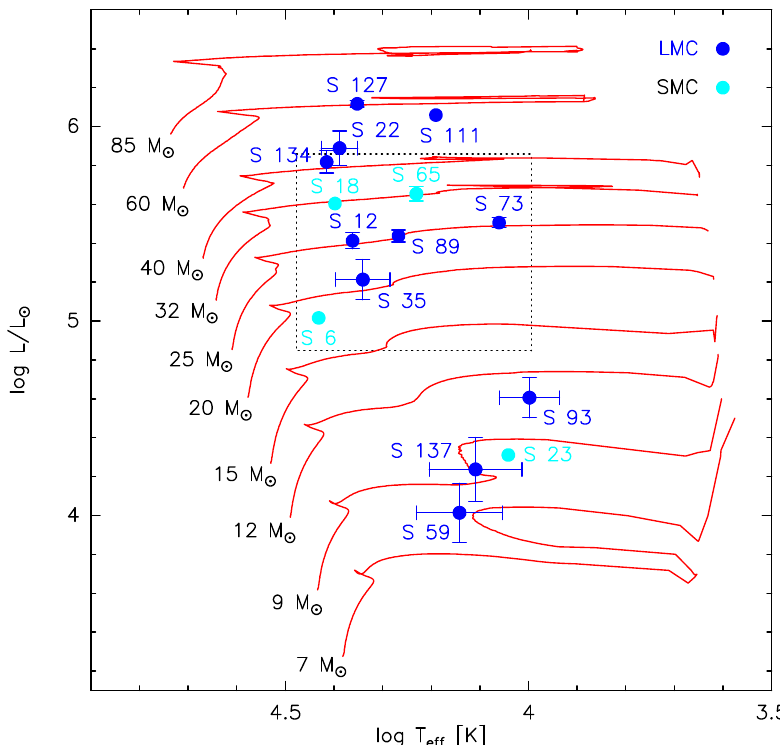
Figure 1. HR diagram showing the positions of the classical MC B[e]SG sample [18]. The stellar evolutionary tracks at SMC metallicity for stars rotating initially with 40% of their critical velocity are also included (from [19]). The dotted square contains objects that display CO band emission (except for S89, see Section2.3). For brevity and readability, the identifiers LHA 120 and LHA 115 for objects within the LMC and SMC, respectively, have been omitted. Table 1. Names and parameters of the established B[e]SG sample within the Magellanic Clouds.